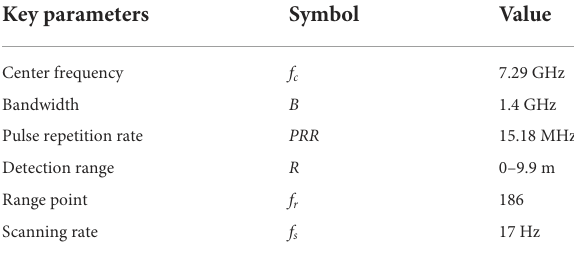
TABLE 1 Key parameters of the UWB radar